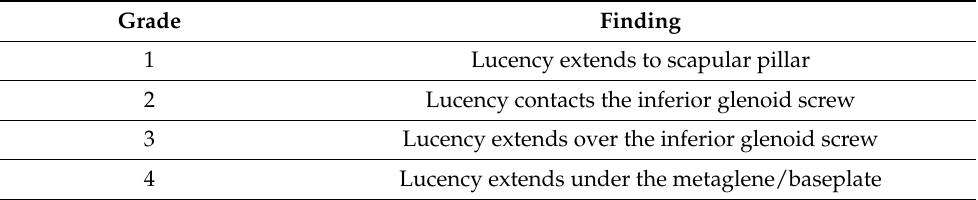
Table 2. Sirveaux classification. Extent of scapular erosion present on radiographs is used to determine the grade of scapular